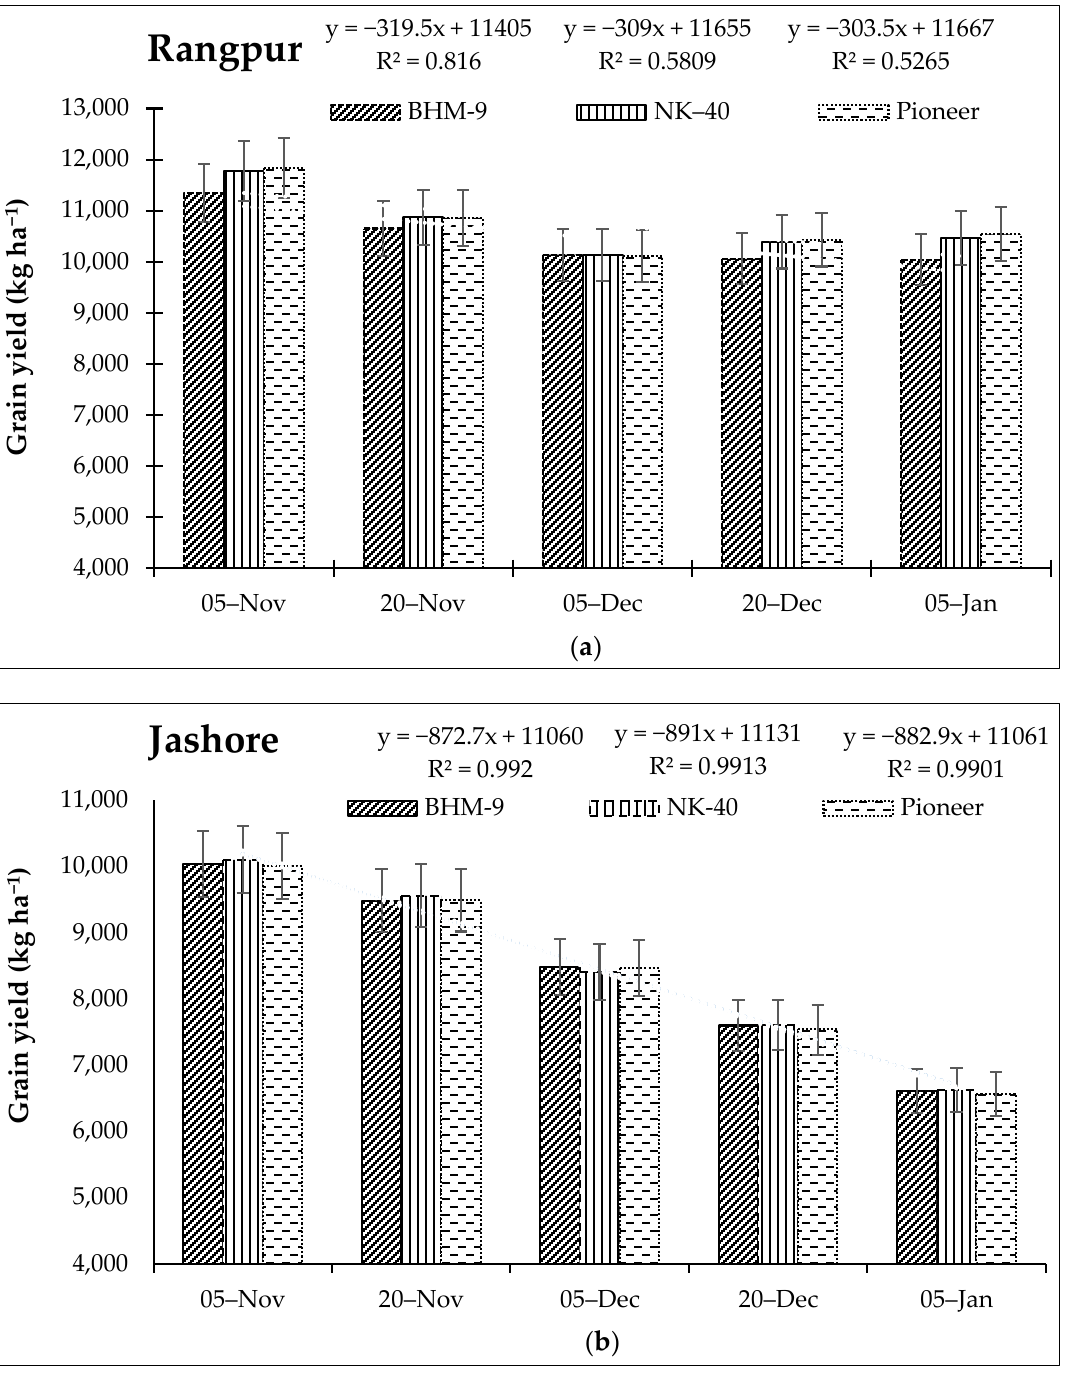
Figure 3. ( a ) Grain yield of maize as affected by sowing dates at Rangpur region considering 30 years of historical data. ( b ) Grain yield of maize as affected by sowing dates at Jashore region considering 30 years of historical data.